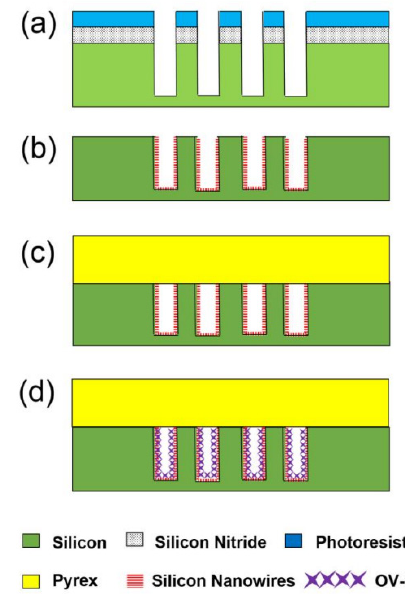
Figure 5: The fabrication process of the μGC column which use silicon nanowires as the stationary phase support and is coated with OV-101.